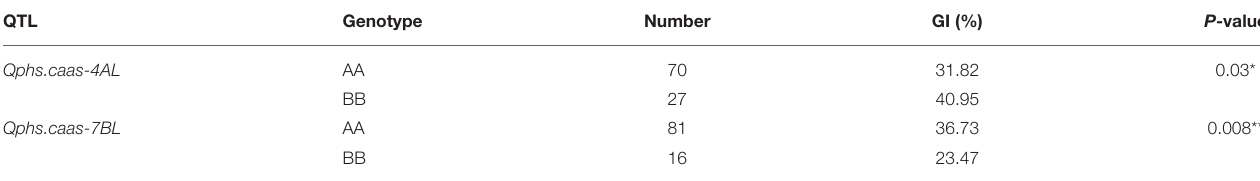
TABLE 2 | The effects of Qphs.caas-4AL and Qphs.caas-7BL on GI in a natural